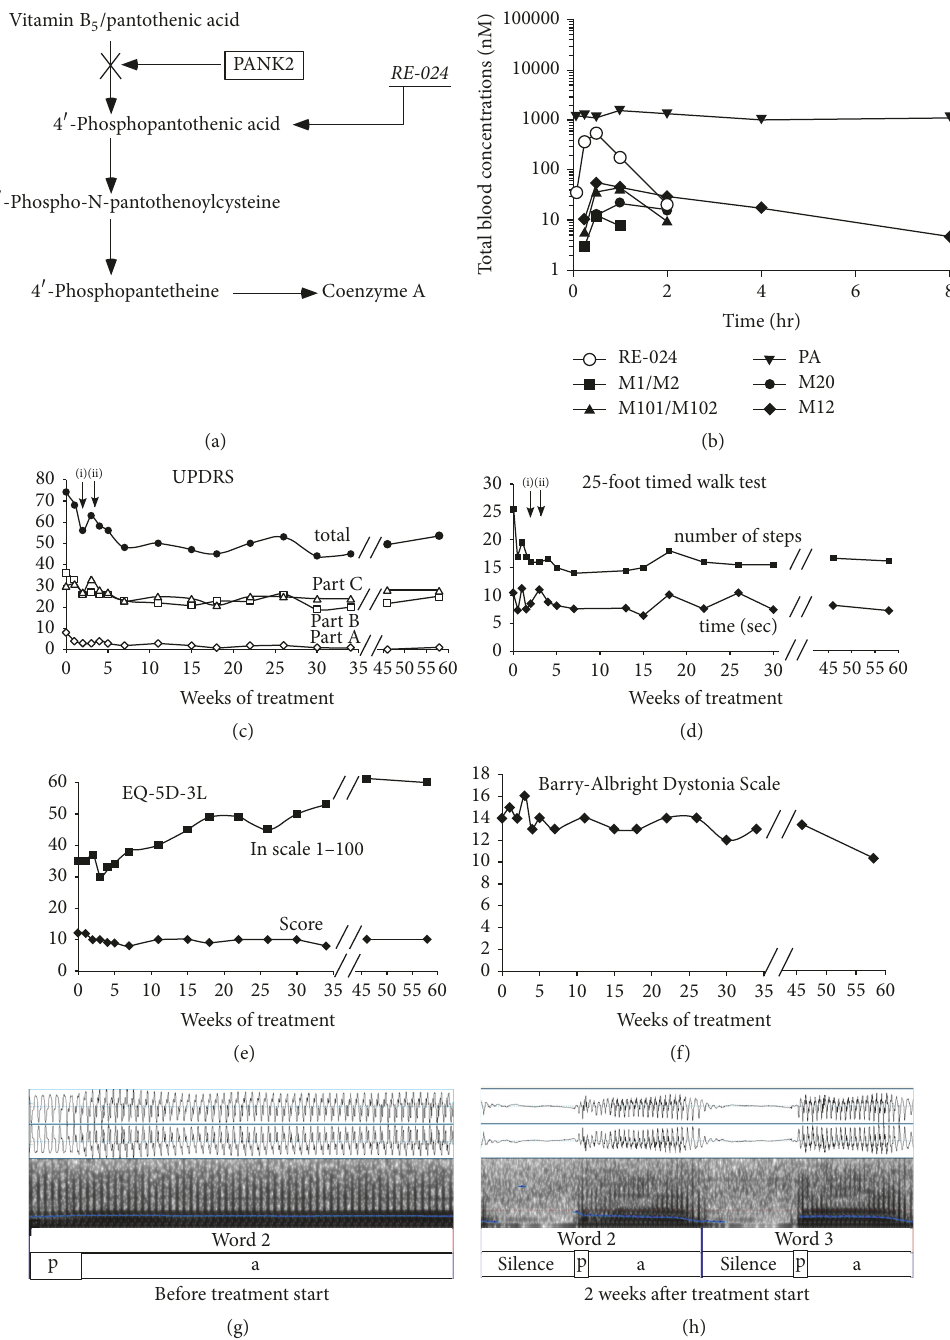
Figure 1: Mode of Action, Pharmacokinetics, and Clinical Effects of Fosmetpantotenate . (a) Diagram showing the metabolic pathway from pantothenic acid to coenzyme A with the pantothenate kinase defect found in PKAN patients and the bypassing effect of fosmetpantotenate. (b) Whole blood concentrations of fosmetpantotenate and metabolites over time following a 1mg/kg oral dose on Day 7 of treatment. (c–f) Clinical evaluations before and after 58 weeks of treatment with fosmetpantotenate. (c) Unified Parkinson’s Disease Rating Scale (UPDRS) including parts C and D and total score. (d) Timed 25-foot gait test including number of steps and time to complete (arrows in diagrams (c) and (d) indicate (i) interruption of treatment; (ii) restarting treatment at half dose). (e) Quality of life scale (EQ-5D-3L). (f) Barry-Albright Dystonia Scale. (g-h) Representative illustrations of electroglottographic analysis [8] before (g) and two weeks after (h) starting treatment showing individual /pa/ segmentation. Before treatment there is an apparent trend to prolong the vowel while after medication there is a significant improvement in the production of